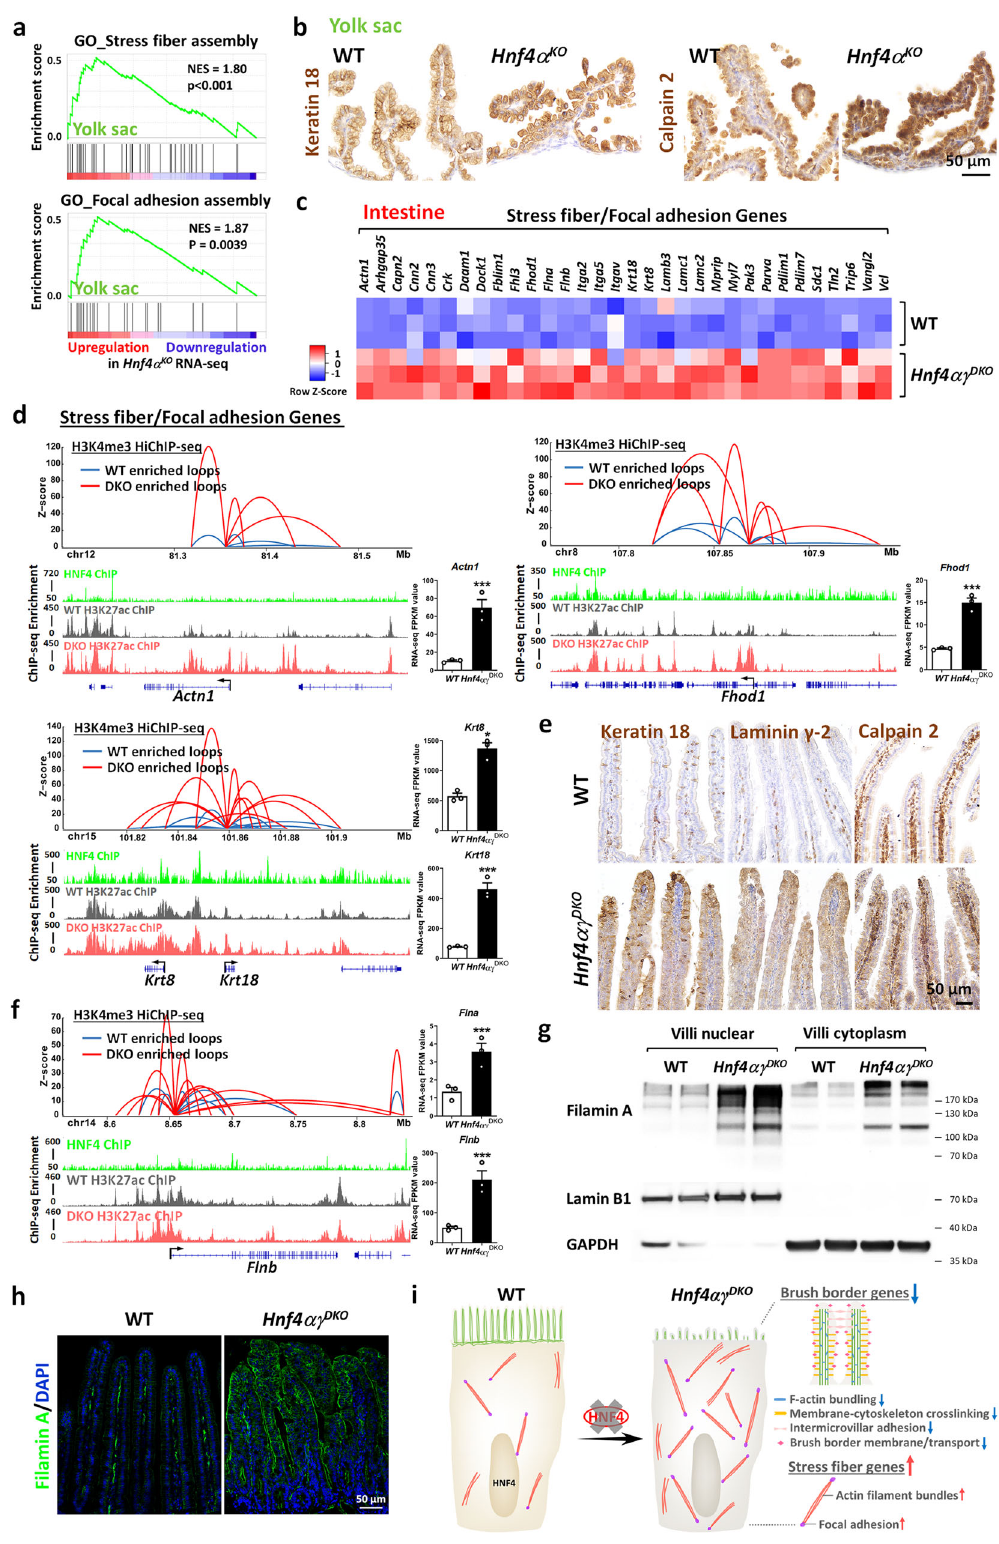
staining was imaged with a Lumenera INFINITY3 camera and in fi nity capture imaging software (v6.5.6). A Zeiss Axiovert 200 M fl uorescence microscope was used for imaging phalloidin staining using a Retiga-SRV CCD (QImaging) and QCapture imaging software (v2.0.8). A Zeiss LSM 510 Meta confocal microscope and Carl Zeiss ZEN 2009 (v5.5.0.451) software were used for imaging the immu- no fl uorescence staining of Hnf4 α (Abcam ab41898, 1:100), Hnf4 γ (Santa Cruz sc- 6558 X, 1:100), β -actin (Abcam ab8227, 1:100), Abcg2 (Kamiya Biochemical Company MC-980, 1 :100), NCC (also known as Thiazide-Sensitive